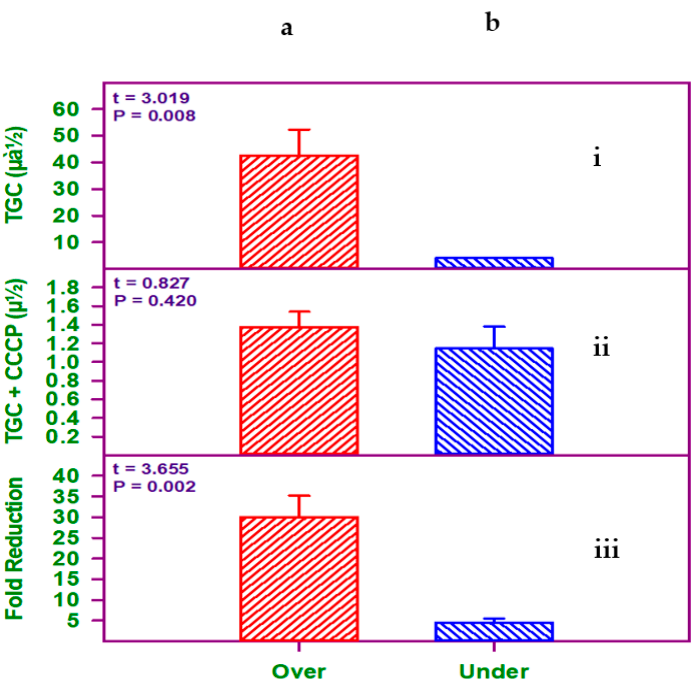
Figure 1. (i) ( a ) Resistant isolates compared with ( b ) intermediate resistance isolates, indicating statistical significance ( p = 0.008) (n = 42 isolates; a = 40 isolates; b = 2 isolates). ( ii ) The fold reduction in tigecycline resistance between the ( a ) resistant isolates and ( b ) the intermediate resistance isolates when treated with CCCP as an EPI. No statistical significance was observed ( p = 0.420) (n = 19 isolates; a = 12 isolates; b = 7 isolates). ( iii ) There was a statistically significant difference between the mean values of ( a ) high expression and ( b ) low expression of the adeB gene according to the qRT-PCR analysis ( p = 0.002) (n = 19 isolates; a = 12 isolates; b = 7 isolates). All values are means ± SEM .